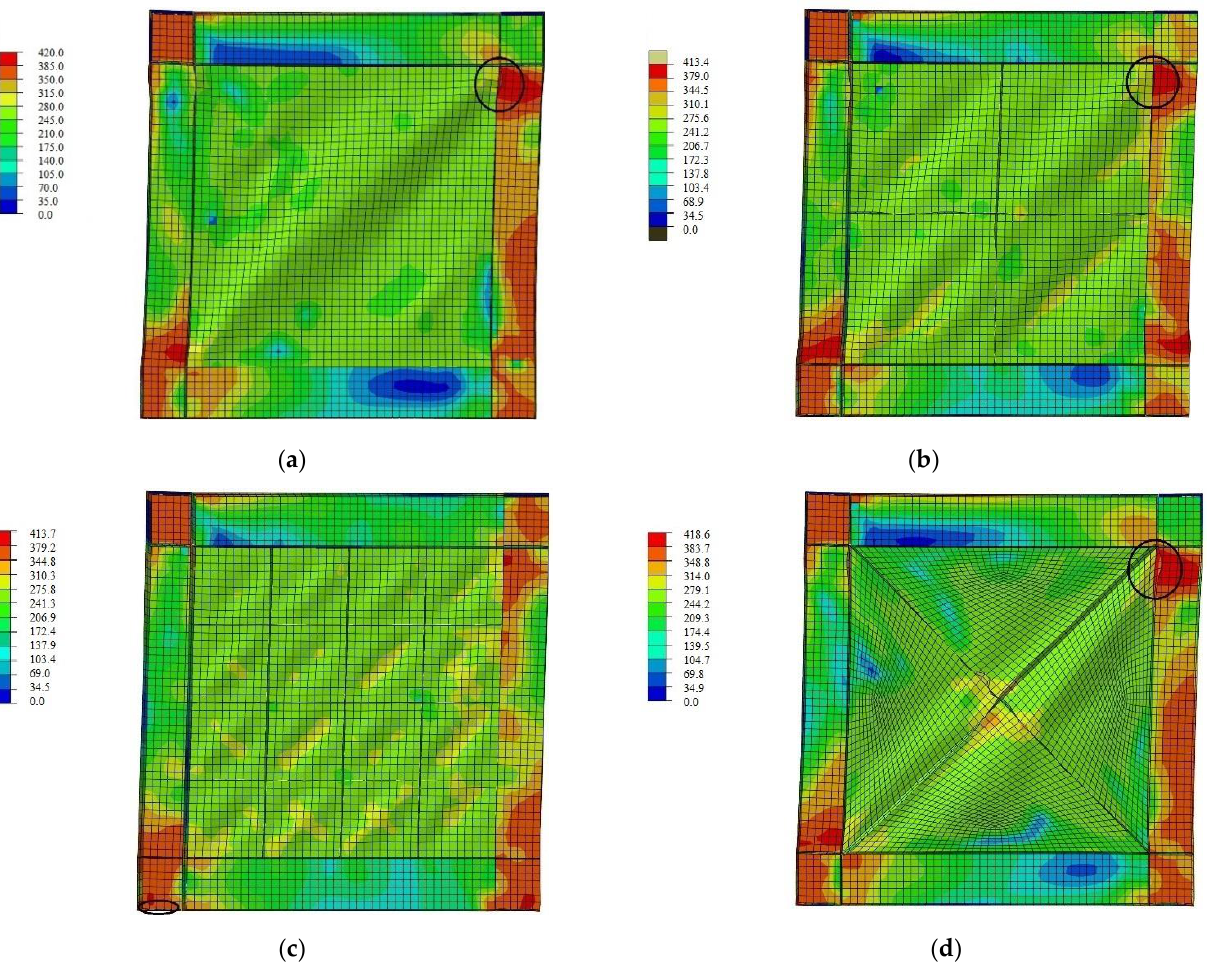
Figure 25. Von Mises stress contour plots of ( a ) USPSW4, ( b ) SPSW4 − 1VHS, ( c ) SPSW4 − 3VHS and ( d ) SPSW4 − DS at the drift ratio of 2.5% (unit: MPa). ( d ) SPSW4 − DS at the drift ratio of 2.5% (unit: